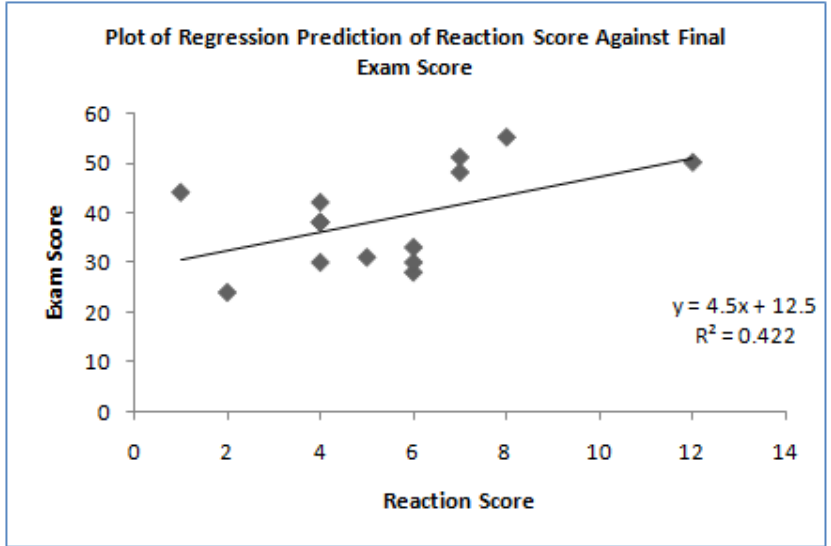
Figure 6. Regression Analysis for group A Reacton Score vs. Exam